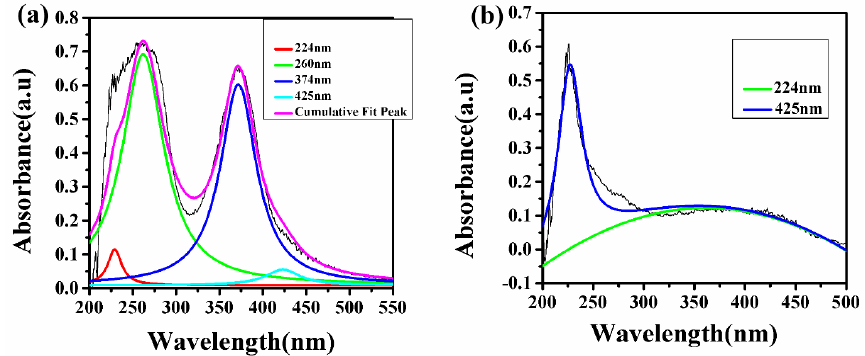
Figure 10. UV–Vis spectrum of tainted (S5) and pure (S6) C. longa (turmeric powder). ( a ) Sample (S5) ( b ) Sample (S6). ( b ) Sample